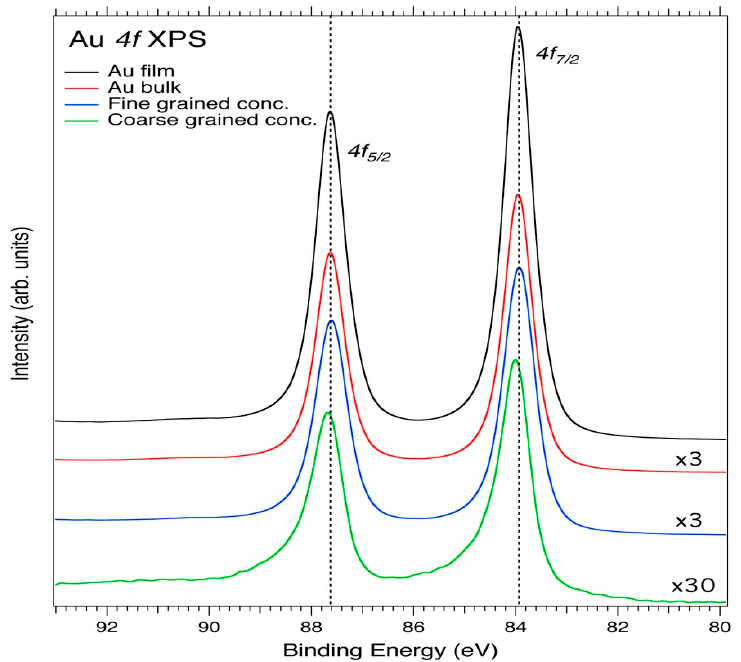
Figure 5. Au 4 f core-level XPS spectra of the Au film, Au bulk, fine-grained Au concentrate, and coarse-grained Au concentrate. The dashed line connects the 4 f peaks as well as the apparent spin- orbit-splitting maxima. The spectra containing lower Au concentrations were scaled-up by factors of 3 and 30 for comparison. For comparison, in the Au powder sample, the 4f 5/2 is located at 87.77 eV and the 4f 7/2 peak at 84.09 eV. The Au 4 f peaks are asymmetric, while the shape of the untreated Au with tails toward higher BE. The chemical shift of 0.14 eV towards higher BE for the pow- der samples suggests that there is a charge transfer from Au towards the other elements.